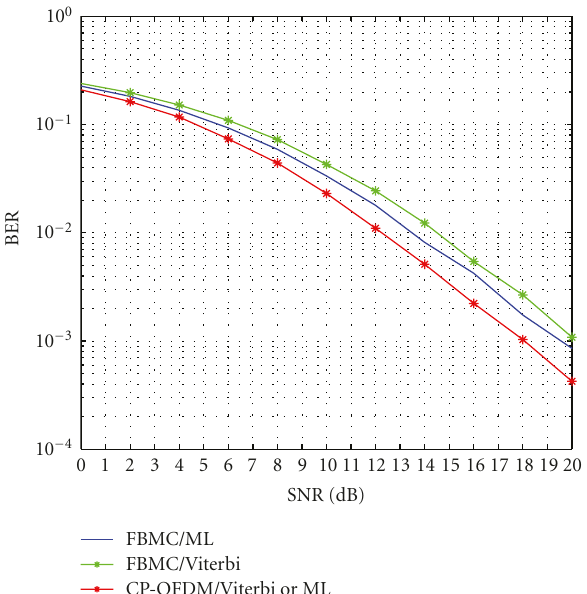
Figure 6: Performance of single delay STTC (iterative decoding) with 2 transmit antennas and one receive antenna (FBMC and CP- OFDM